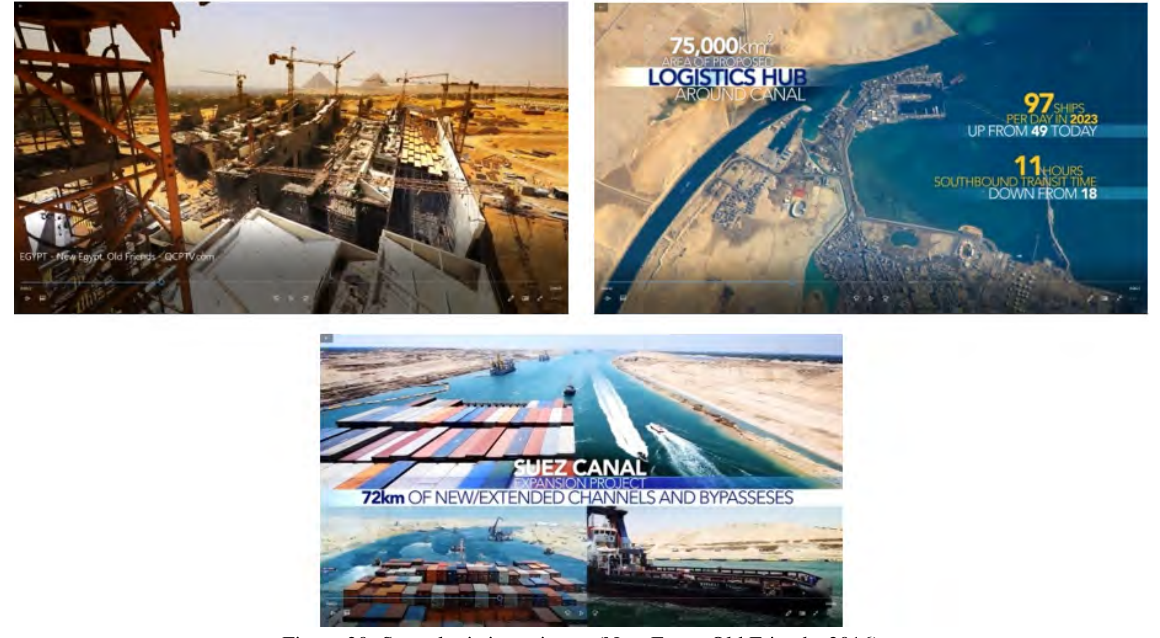
Figure 20. Some logistic projectcs (New Egypt Old Friends, 2016)